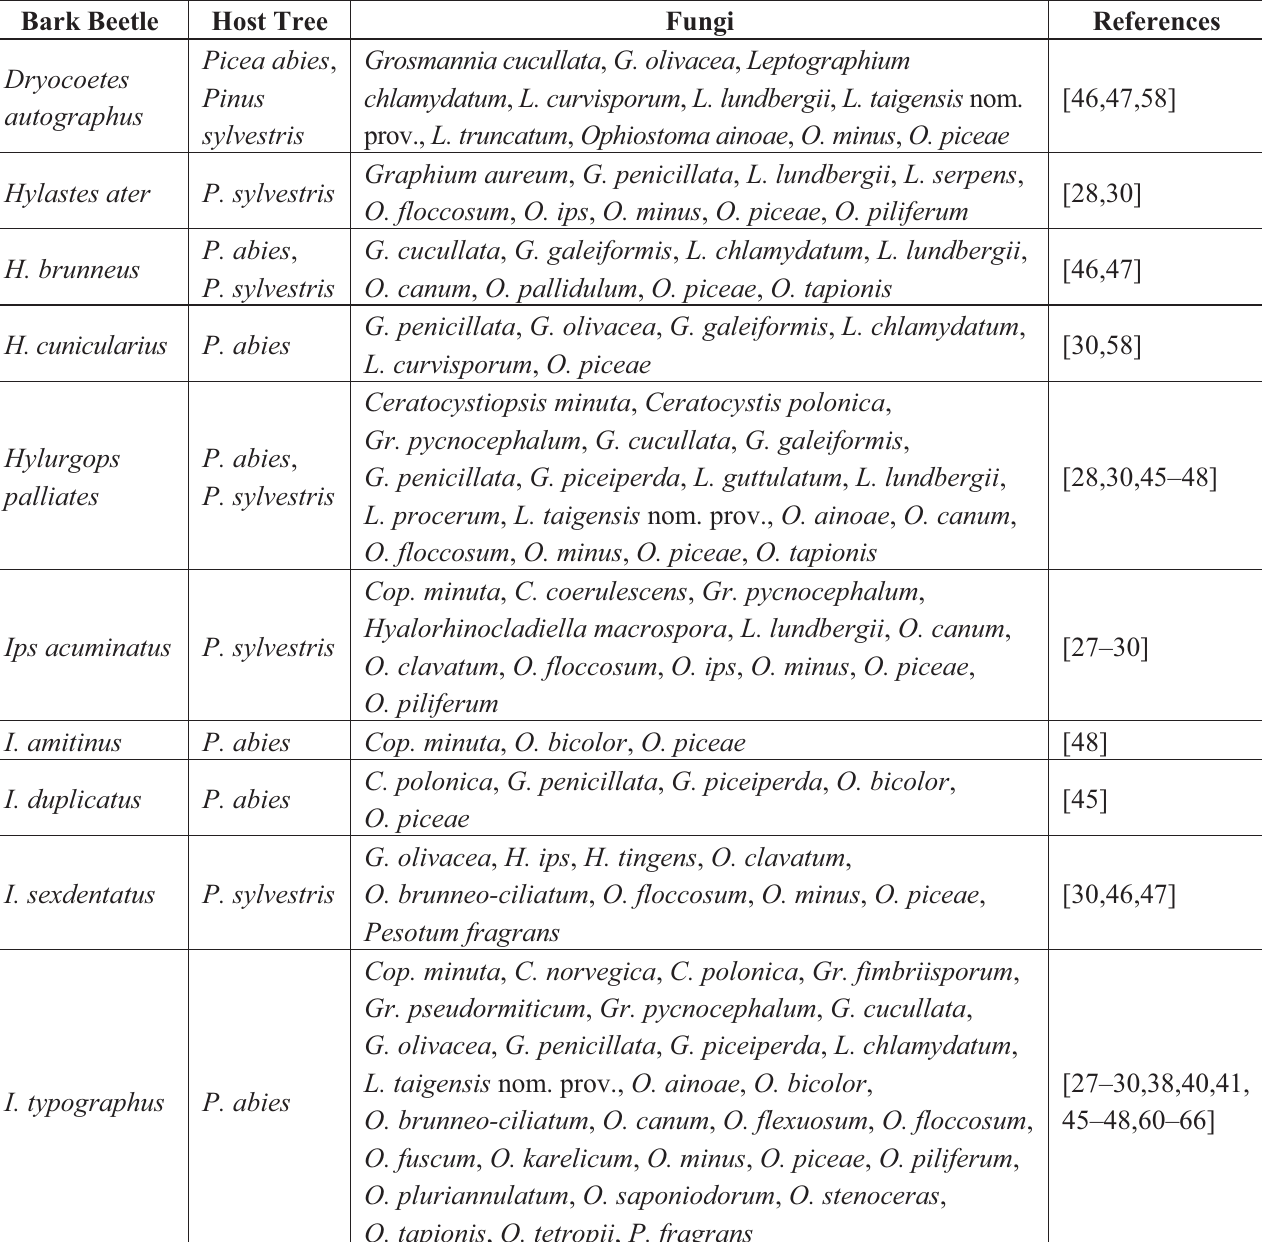
Table 1. Ophiostomatoid fungi associated with conifer-infesting bark beetles in Fennoscandia. Bark Beetle Host Tree